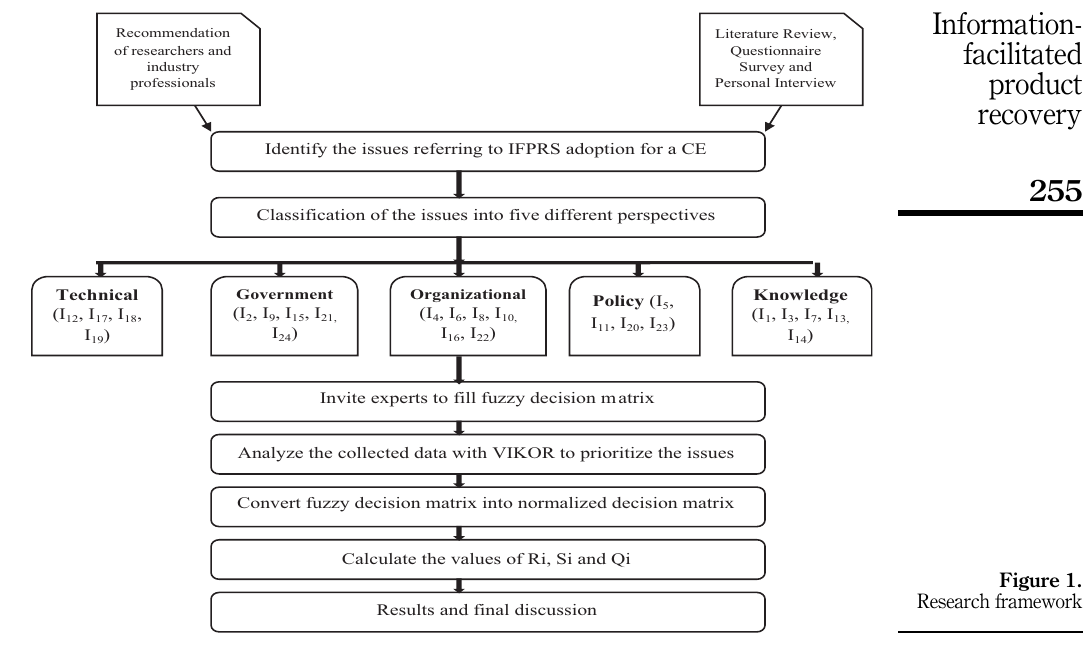
Figure 1. Research